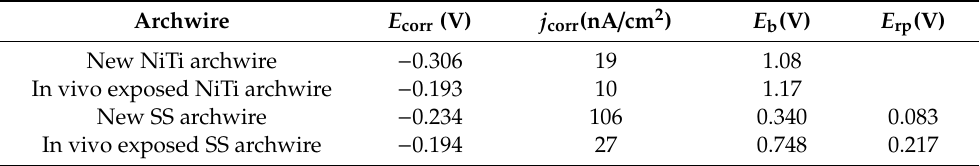
Table 2. Electrochemical properties derived from cyclic polarization curves, presented in Figure 2. Archwire E corr (V) New NiTi archwire − 0.306 In vivo exposed NiTi